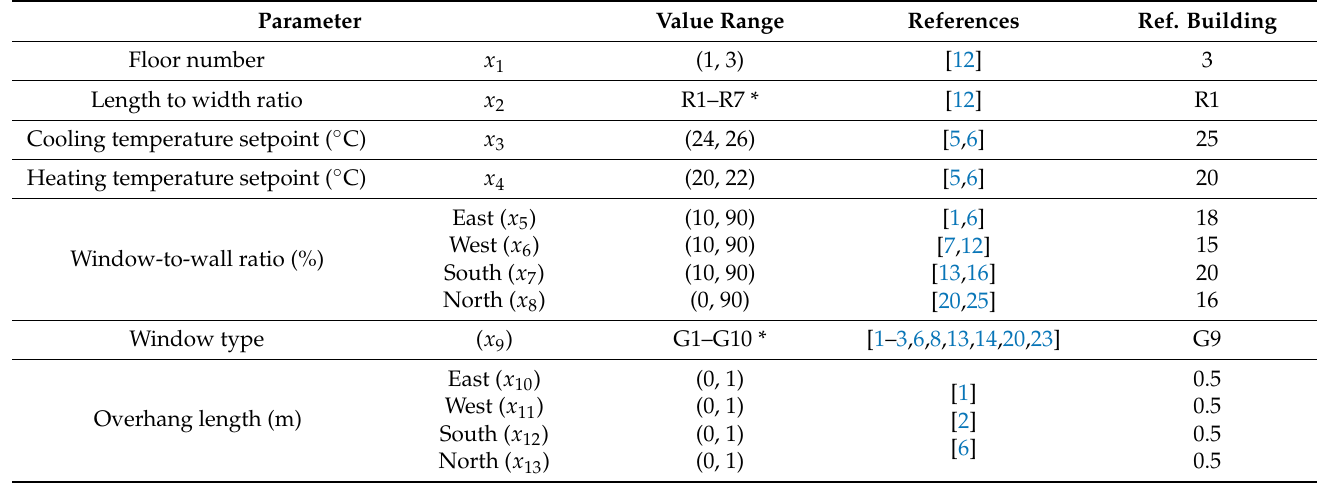
Table 3. Design parameters and value ranges.